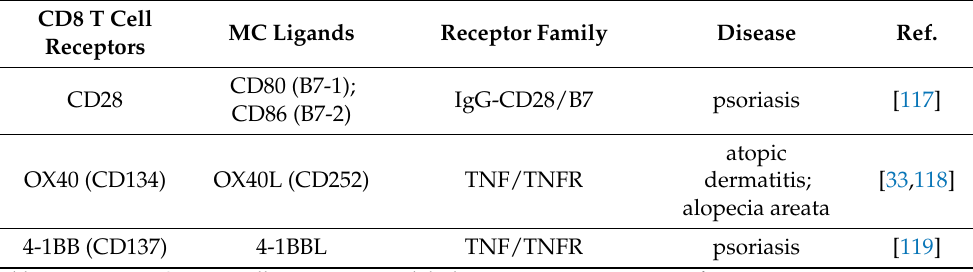
Table 2. Costimulatory molecules and their ligands in skin